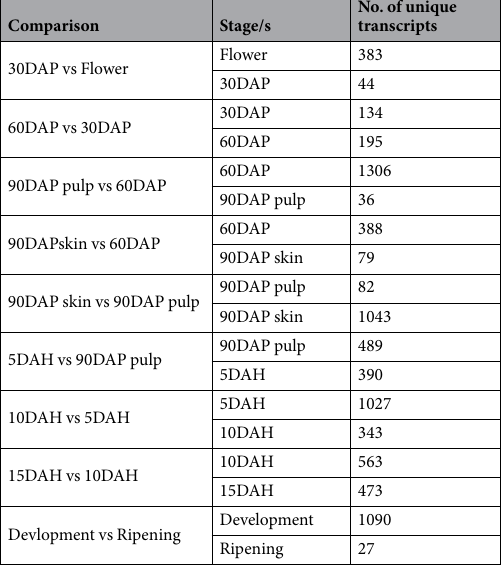
Table 4. Distinct